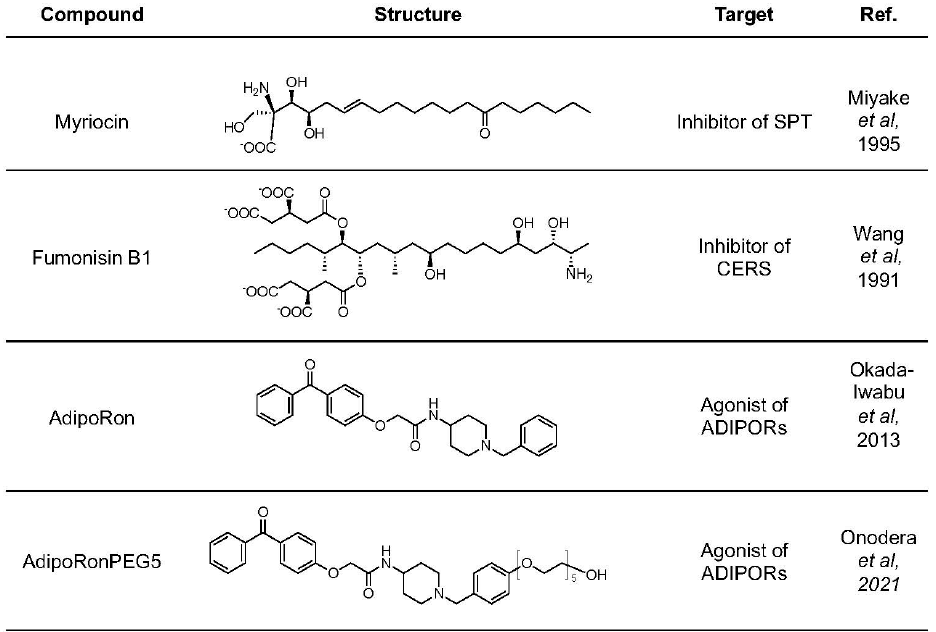
Figure 4. Pharmacological agents targeting ceramide metabolism and adiponectin receptors. Cor- responding references for these compounds are [91], [93], [103], and [8], respectively (from top to bottom).